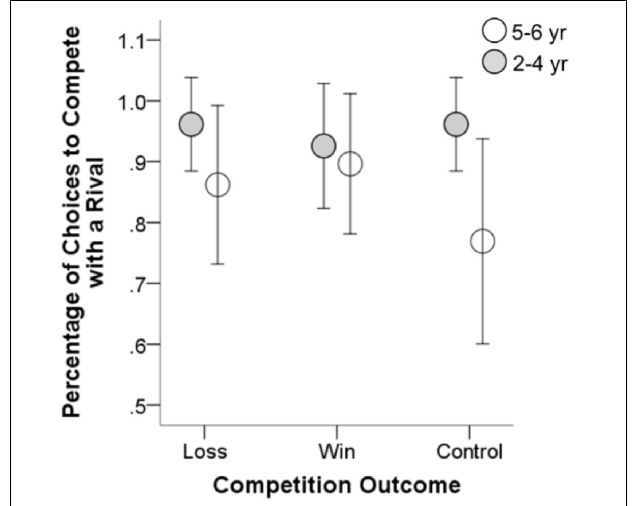
FIGURE 1 | Mean percentage of choices to compete with a rival as a function of age and competition outcome. Error bars represent 95% confidence intervals.